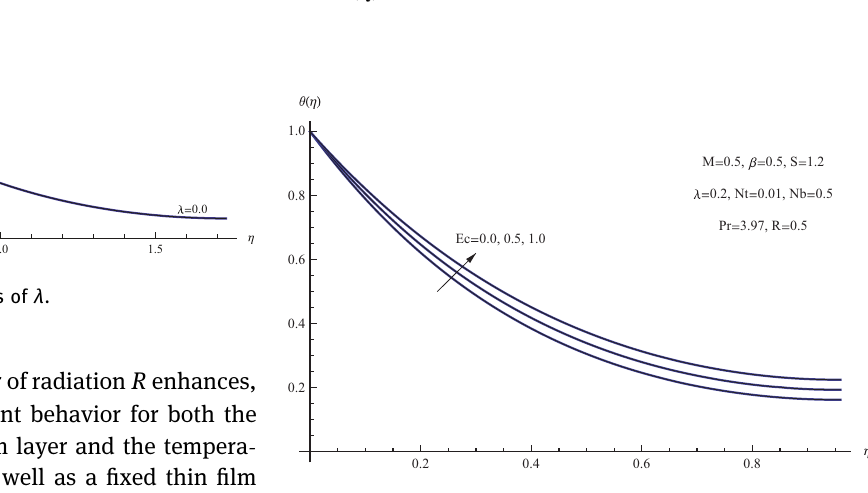
Figure 15: ( ) θ η for assorted quantities of